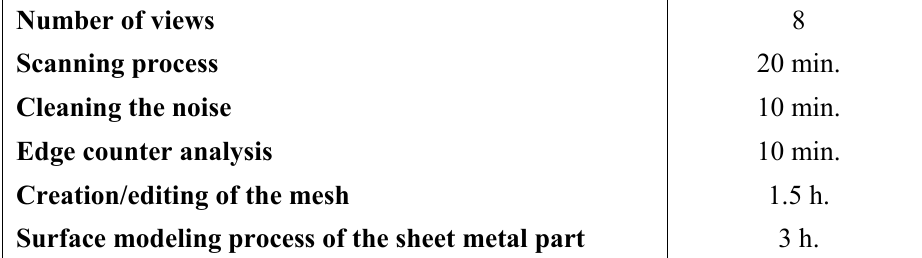
Table 2. Average duration of each task in scanning process and designing the sheet CAD model. Number of views 8 Scanning process